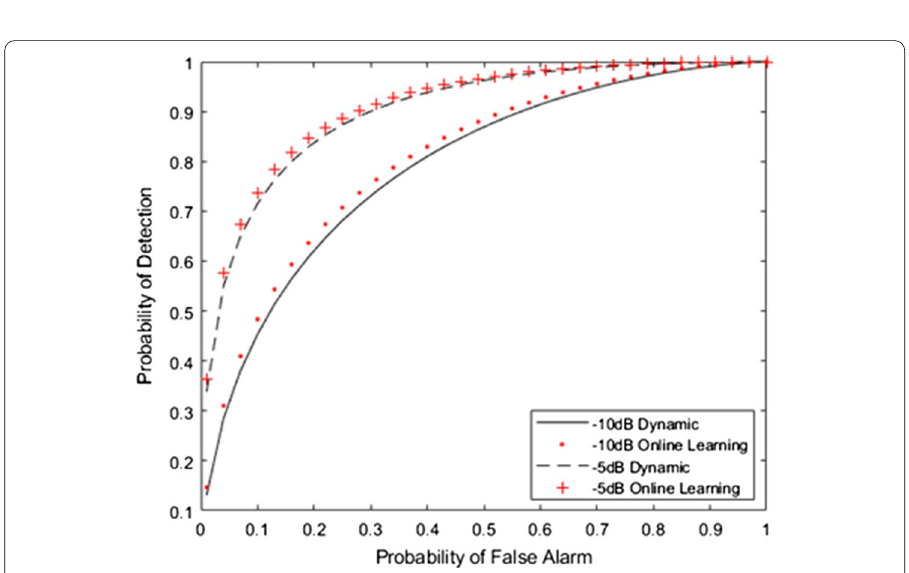
Fig. 10 ROC ( P d vs P fa ) of Matched filter detection sensing under Rayleigh fading